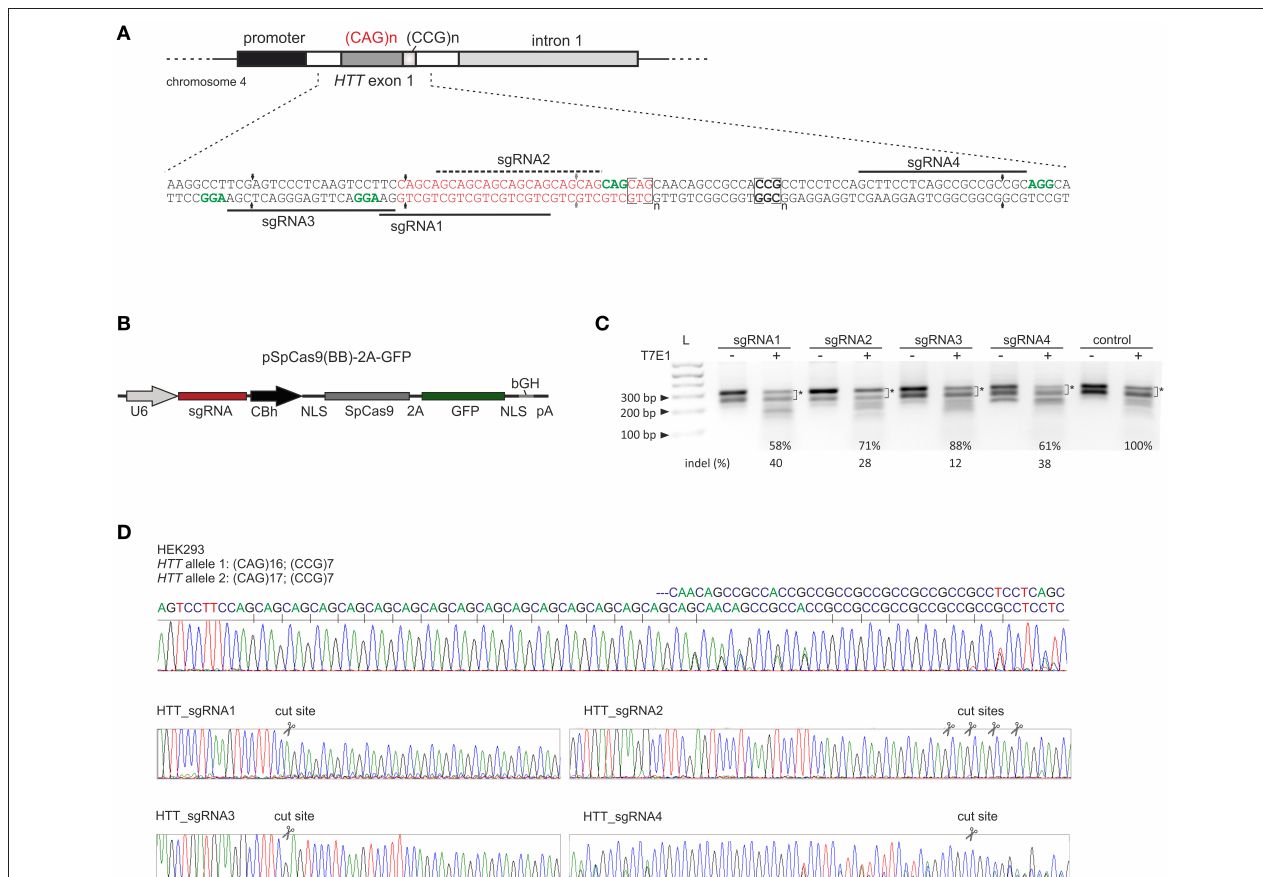
FIGURE 1 | Pre-screening of HTT_sgRNAs activity in HEK293T cells. (A) Polymorphic CAG repeats and the following CCG repeats are located in exon 1 of the HTT gene. sgRNA1, sgRNA3 and sgRNA4 were designed to target the 5 ′ - and 3 ′ -repeat flanking sequences, respectively. Appropriate PAM sequences are highlighted in green. SgRNA2 uses a non-canonical NAG PAM sequence and targets CAG repeats directly. (B) Illustration depicting the CRISPR/Cas9 expression plasmid used to co-express the SpCas9 protein together with the GFP reporter marker and sgRNA under the U6 promoter. NLS, nuclear localization signal. (C) Analysis of HTT_sgRNA and wt Cas9 activity in HEK293T cells by T7E1 mismatch assays. The signal intensities of the two main bands (marked with an asterisk) was measured. The loss of this signal in relation to the control (100%) was used to calculate the indel frequency (%) in the samples treated with T7E1 ( + ). The length of the main PCR product is ∼ 305 bp. Additional, faster migrating bands in samples non treated with T7E1 enzyme are secondary structure forms of the main product and their contribution is significantly reduced after denaturation of a sample directly before gel electrophoresis (see Figure S1 ). (D) Sanger sequencing of the HTT gene fragment included the CAG repeat tract. HEK293T cells are heterozygous in this locus with two alleles containing 16 and 17 CAG repeats. After HTT gene editing with CRISPR/Cas9, the sequence trace after the break site comprised a mixture of signals derived from the unmodified and modified DNA.